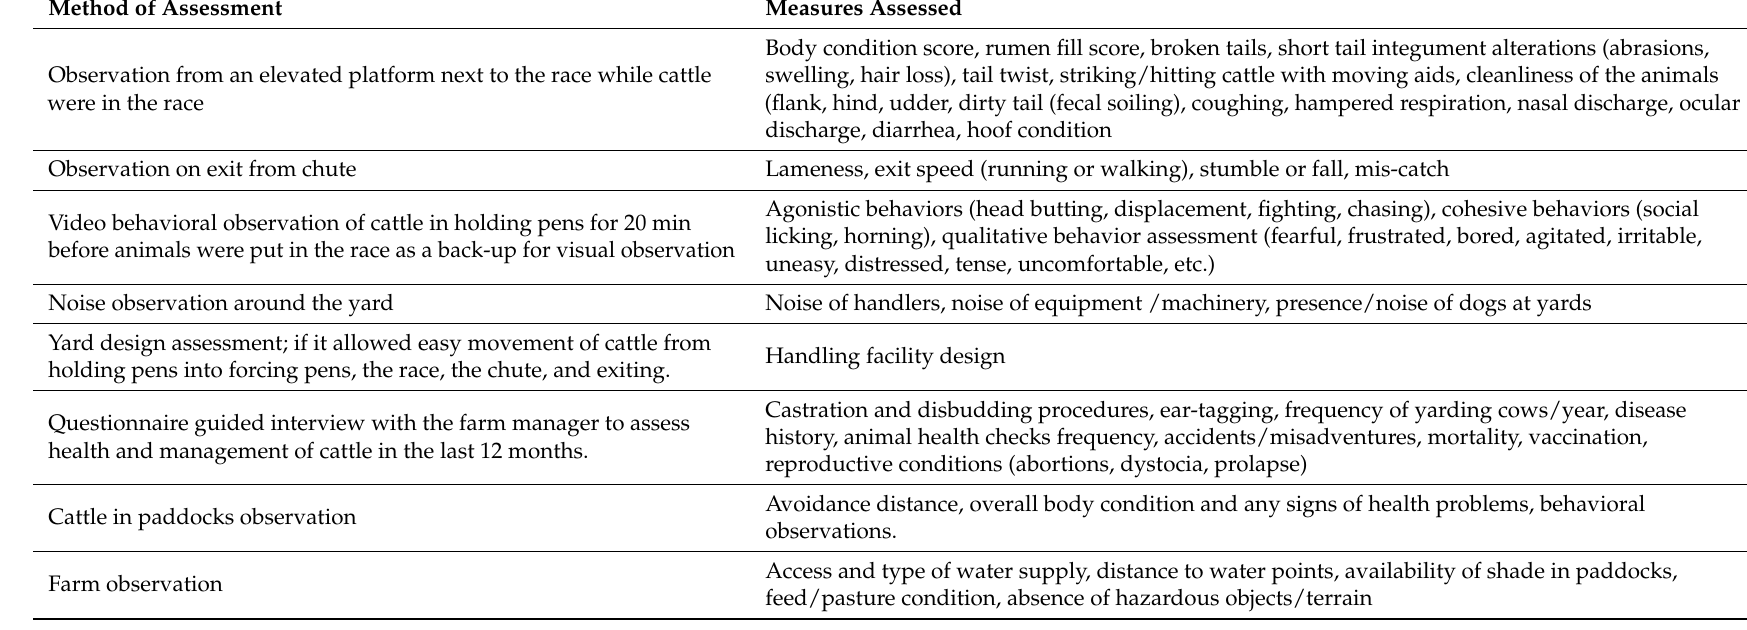
Table 2. Identified suitable measures and methods of